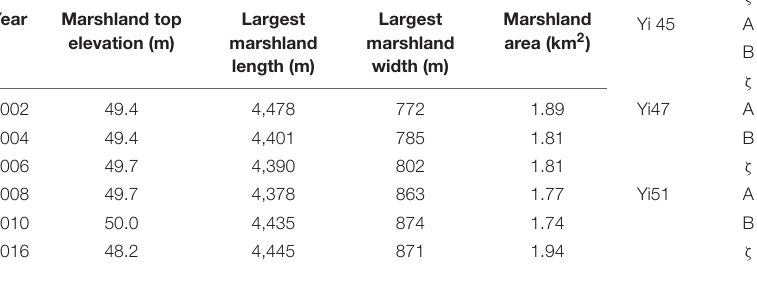
TABLE 2 | Statistics of the characteristic values of Yanzhiba marshlands under the water depth of 39 m from 2002 to 2016.